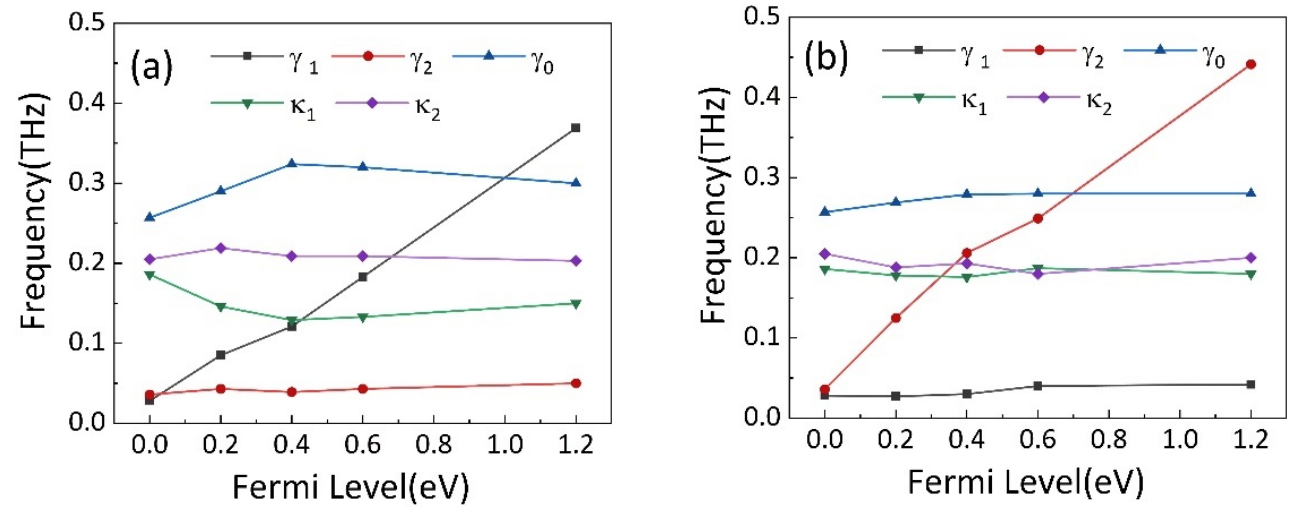
Figure 6. The variations of γ 1 , γ 2 , γ 0 , κ 1 and κ 2 with different Fermi levels of ( a ) strip 2 and ( b ) strip 1.